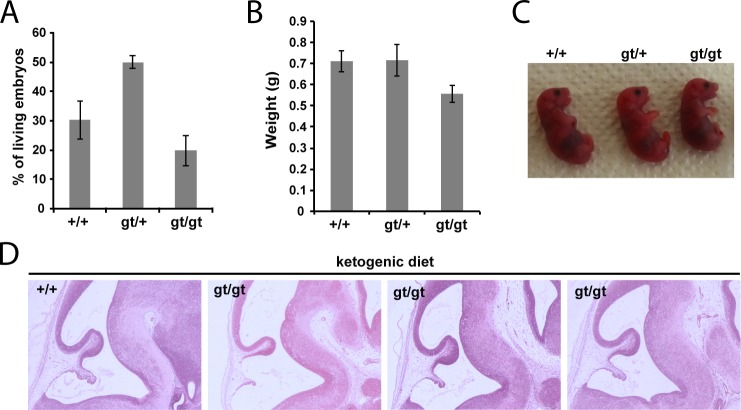
Ketogenic diet rescues embryonic lethality of MPC1 disruption.(A) Genotypes of live, C-section-delivered E18.5 pups derived from heterozygous MPC1gt/+ breeding where the pregnant dam was fed a ketogenic diet from E8.5 onwards. (B) Weights of C-section-delivered E18.5 pups derived from the same breeding as in (A). (C) Apart from a slightly smaller size, C-section-delivered E18.5 MPC1gt/gt pups look outwardly normal. (D) Paraffin-embedded E13.5 embryo sections derived from a ketogenic diet-fed dam were stained with H&E. Note that the lesions in the pons region of MPC1gt/gt embryonic brains are rescued by the ketogenic diet.